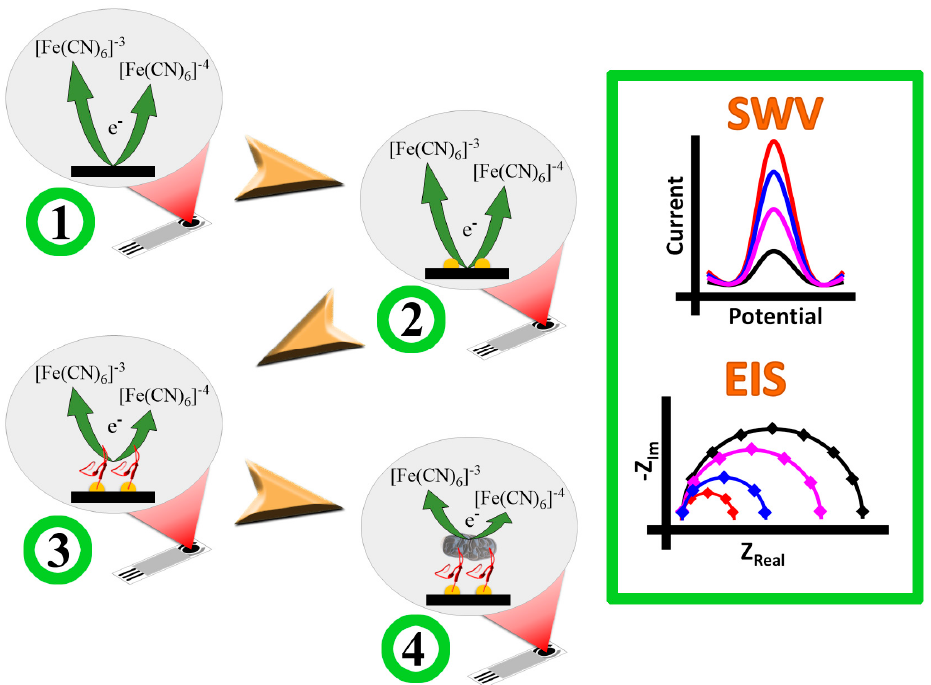
Figure 11. Diagram of the construction of the biosensor and the detection of E. coli . The electro- chemical behavior of unmodified (SPE) the electrode in step 1 ( left ) is schematically represented by black lines in SWV and EIS curves ( right ). The expected response of the electrode is as follows: SPE/AuNPs (step 2 in left, red lines in SWV and EIS), SPE/AuNPs/PEP (step 3 in left, blue lines in SWV and EIS), and SPE/AuNPs/PEP/EC (step 4 in left, rose lines in SWV and